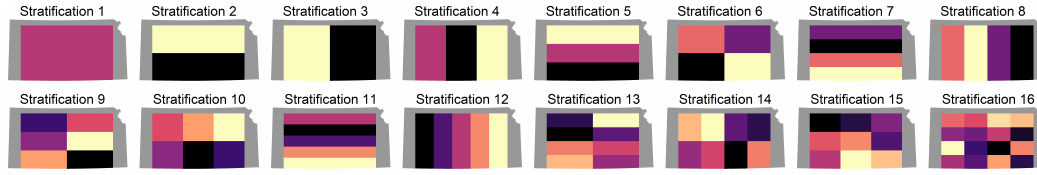
Figure 3. Area of interest in Kansas and the 16 stratification layers. The stratification layers were used to introduce sample selection biases in reference data. Colours represent different strata. Grey areas were not